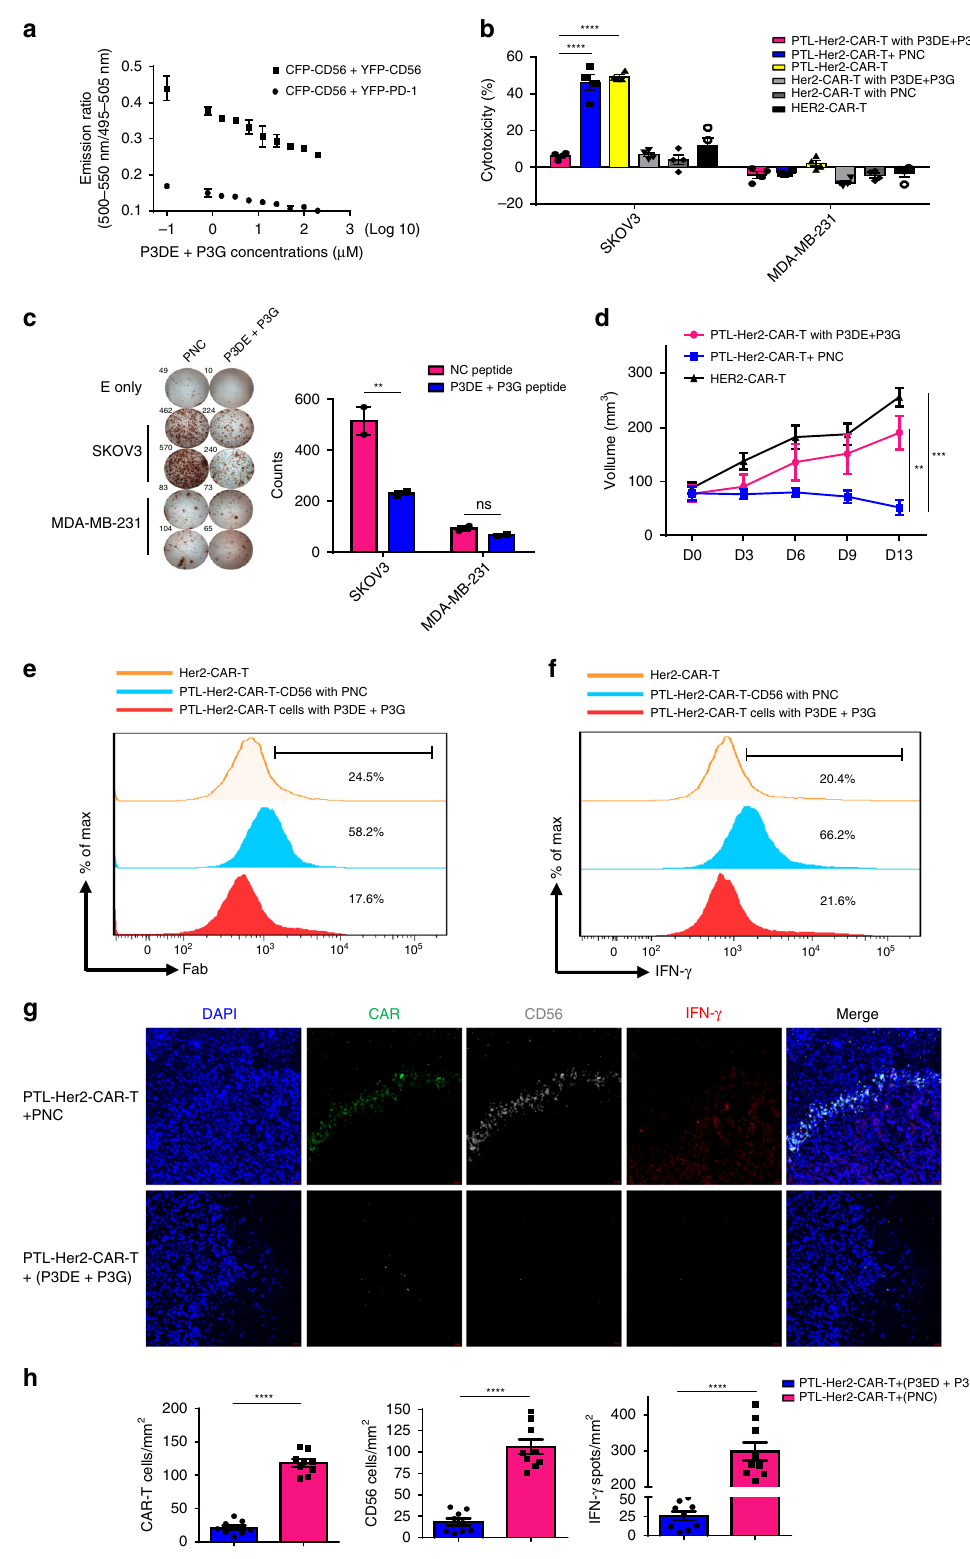
Mice were killed when the mean tumor burden in the control mice reached 1500 – 2000 mm 3 . Some tissues were digested with collagenase type IV (2 mgml − 1 , Sigma) at 37°C for 30 min and tumor-in fi ltrating T cells were separated by centrifugation on a discontinuous Percoll gradient (Haoyang, China). Others were used for immunohistochemistry (IHC) and immuno fl uorescence assays.